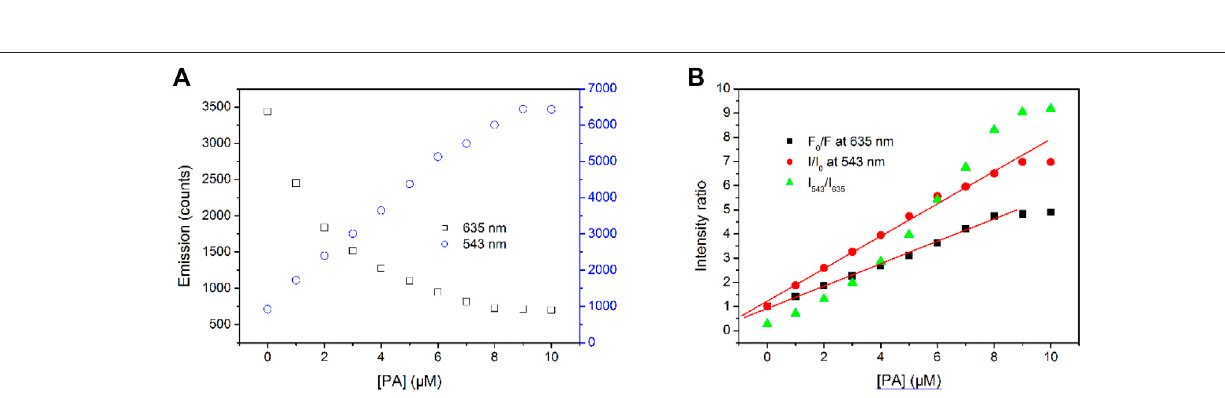
FIGURE 6 | (A) : Emission spectra of Tb-COF with PA concentration of 0 and 10 μ M, inset: corresponding photo, (B) : emission spectra of Tb-COF with increasing PA concentrations from 0 to 10 μ M.